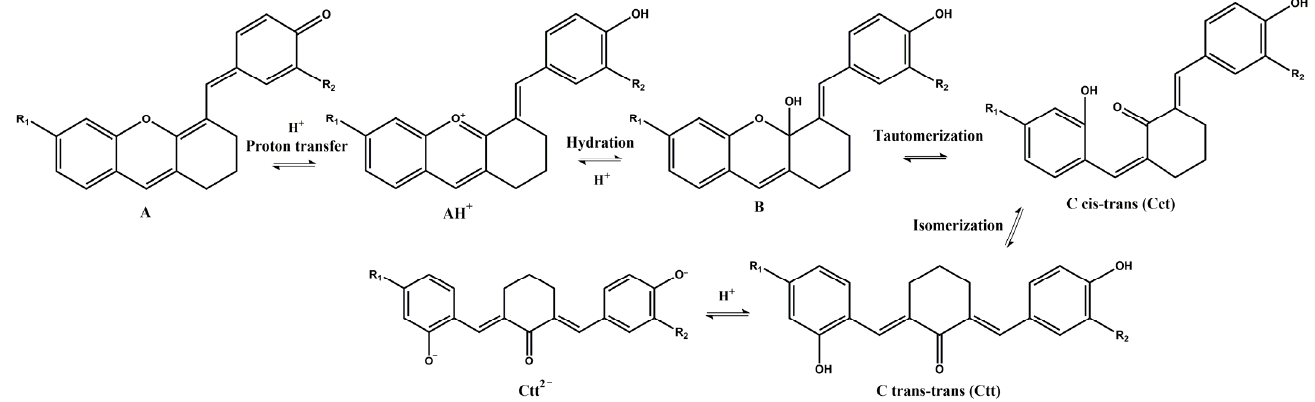
Figure 3. Potential network of chemical reactions involved in the interconversion of the species for compound 3 (R 1 = H; R 2 = OCH 3 ) and compound 4 (R 1 = OCH 3 ; R 2 = H).